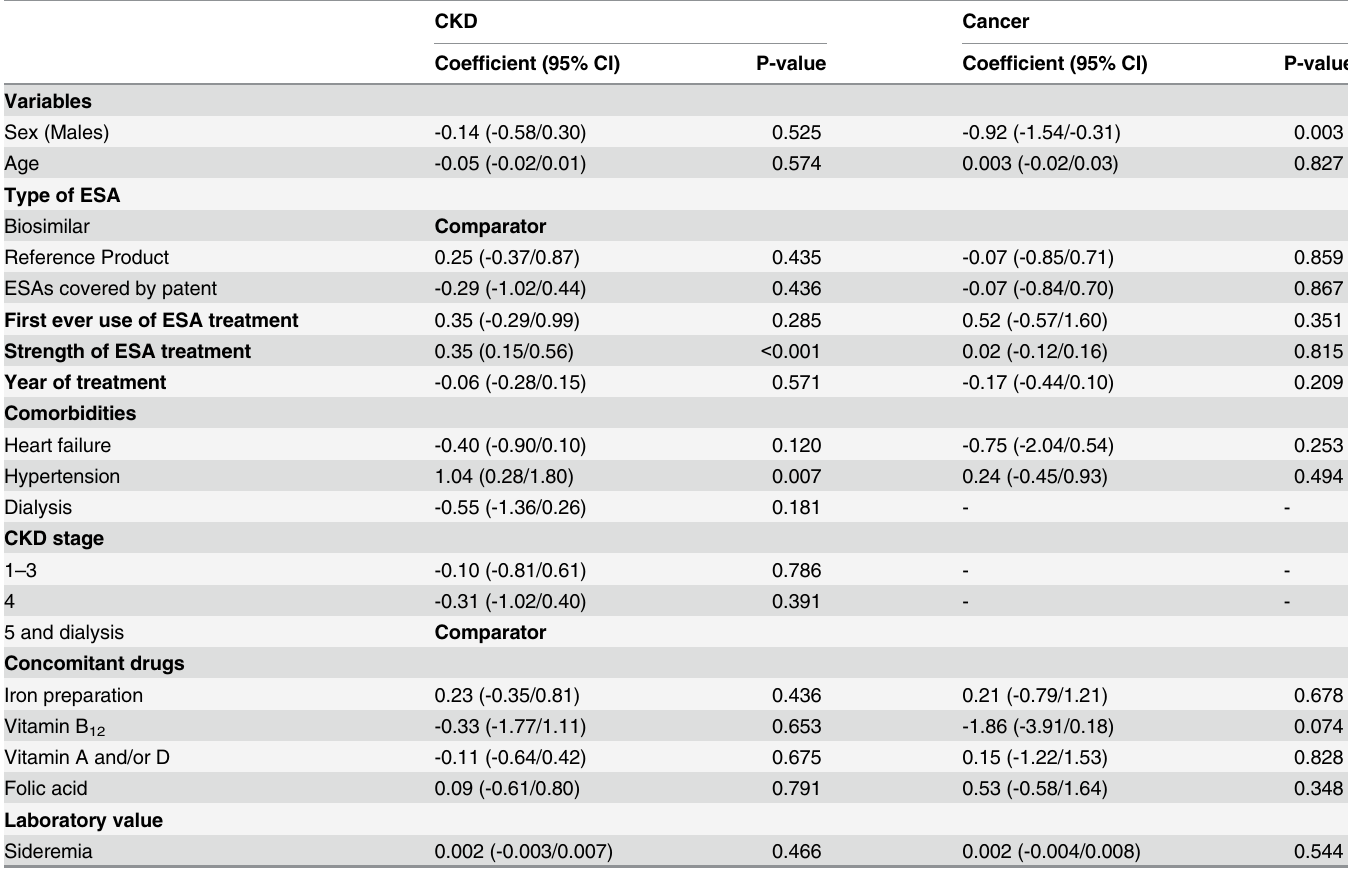
Table 3. Multivariate Ordinal Logistic Regression Model for responsiveness to first three months of ESA